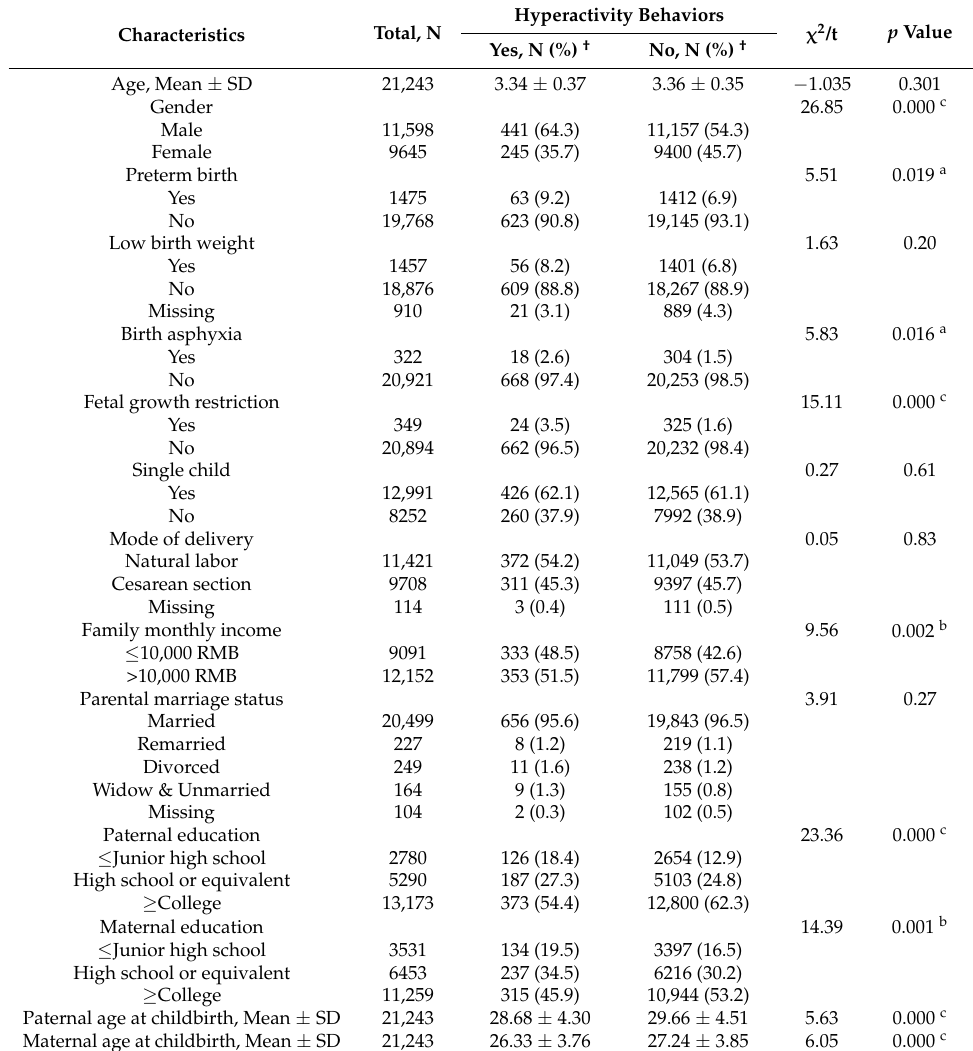
Table 1. Socio-demographic characteristics of participants and their associations with hyperactivity